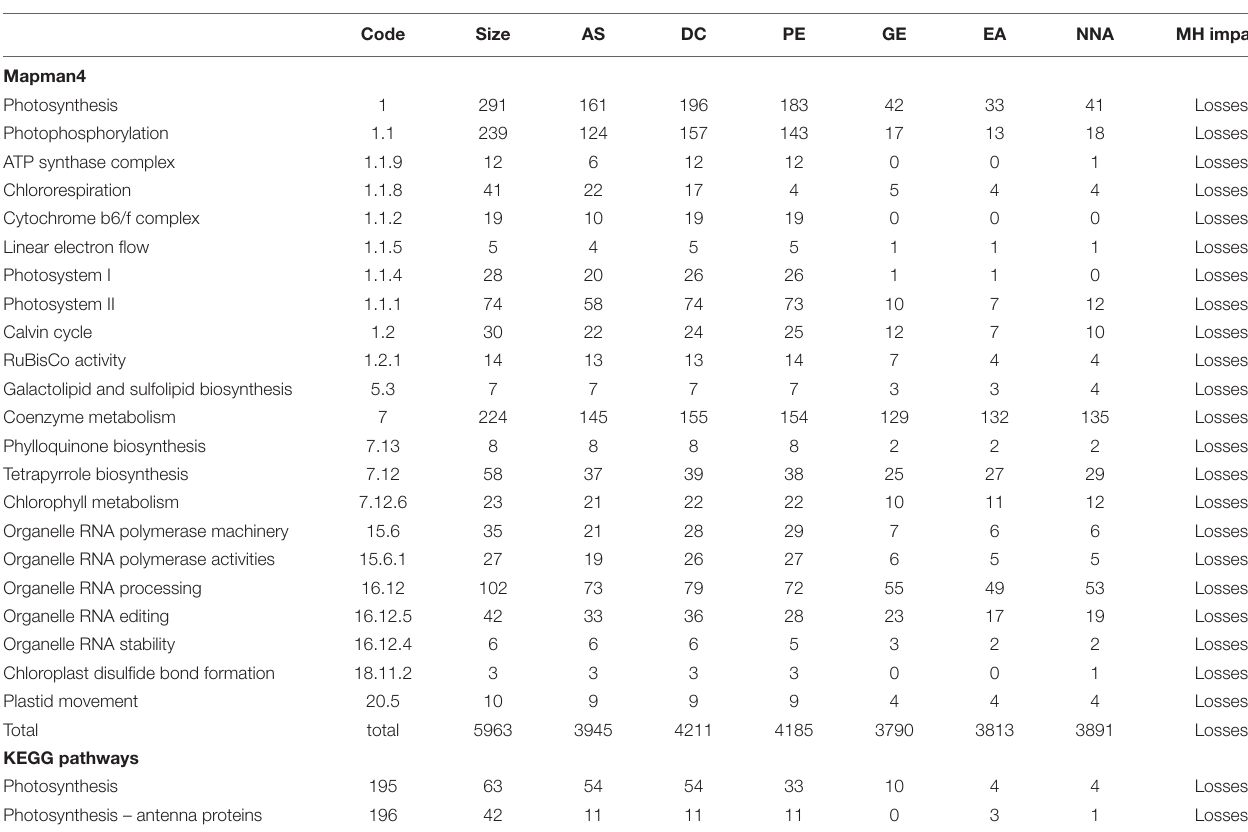
TABLE 2 | Gene content: pathways impacted by the switch to